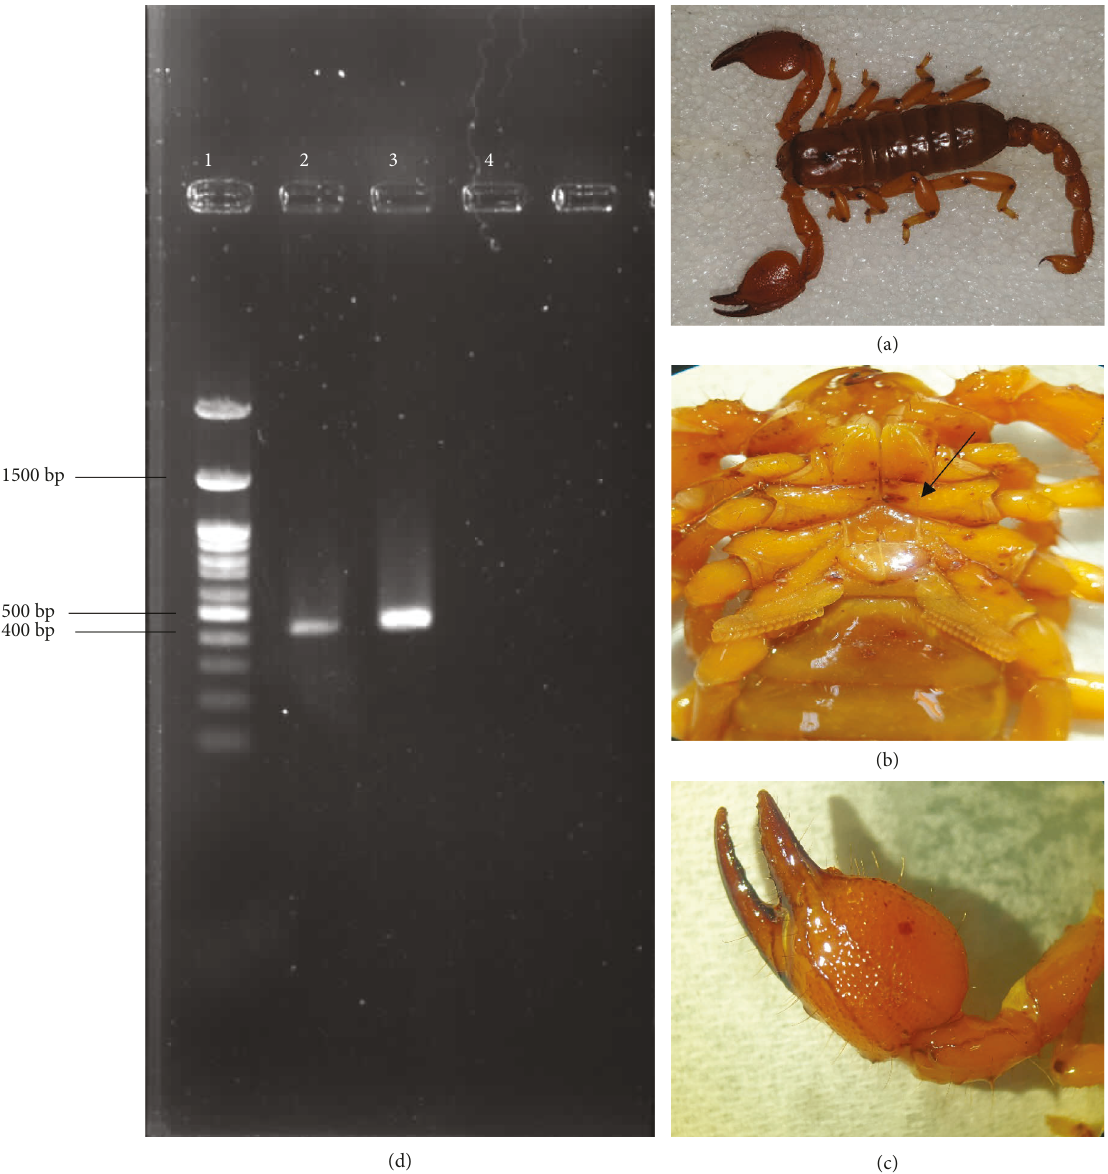
Figure 1: Morphological characteristics of the Scorpio maurus investigated in the current study. The general morphology of S.maurus (a), the pentagonal-shaped sternum of the Scorpionidae family (b), and short and bulky pedipalps (c). Amplification of Maurolipin (Iranian S. maurus PLA ) through RT-PCR using specific primers (d); Lane 1 is ladder 100 (bp) DNA marker, Lanes 2 and 3 are PLA 2 Lane 4 is negative